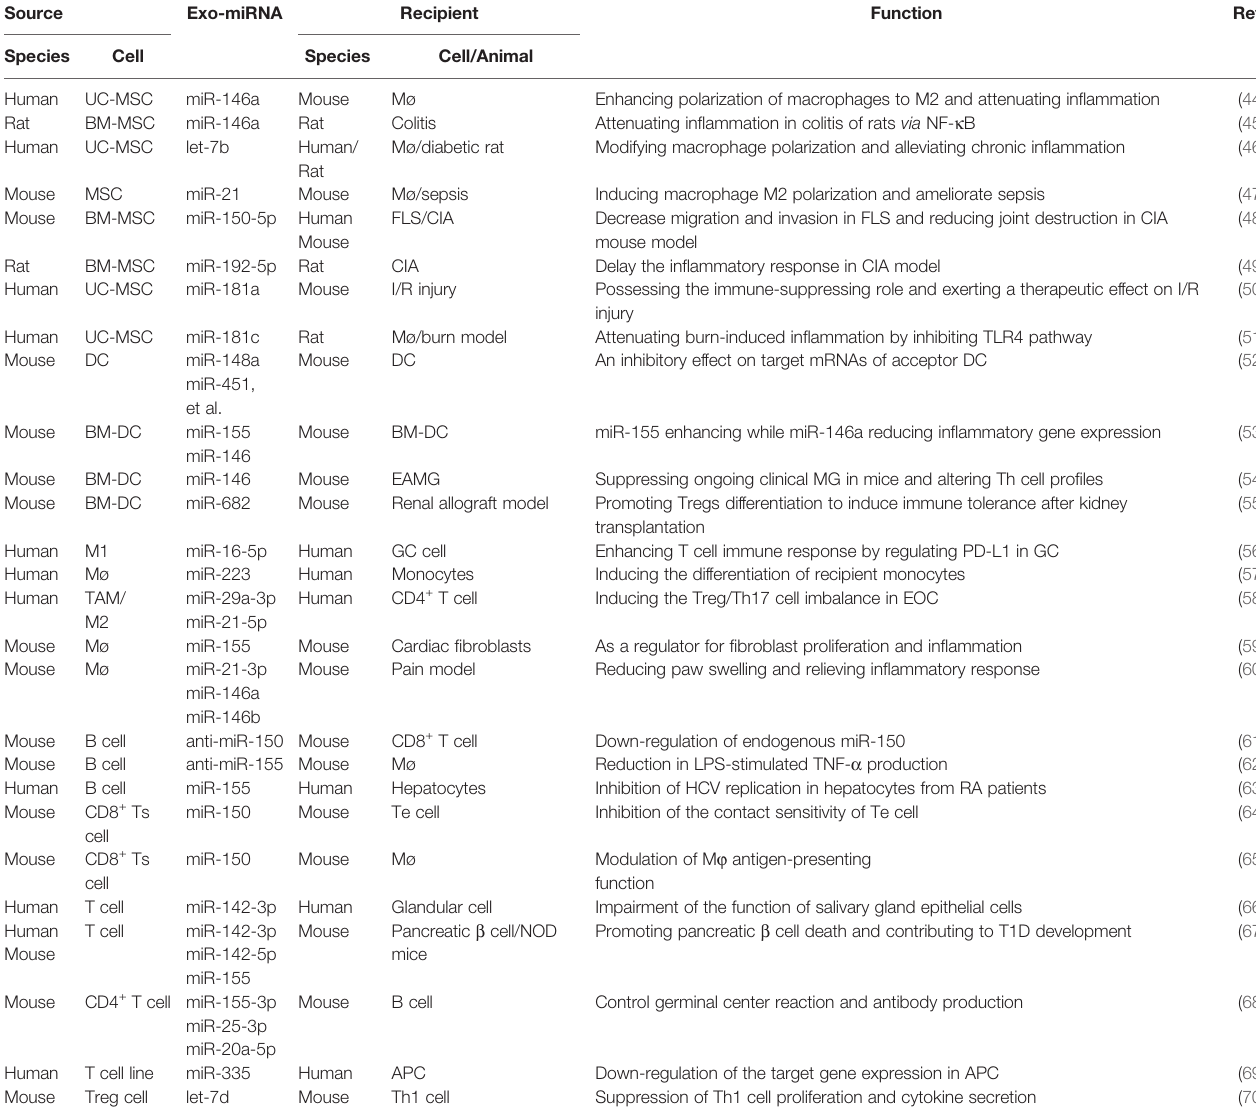
TABLE 1 | Functions of exosome-associated miRNAs in immune modulation. Source Exo-miRNA Recipient Function